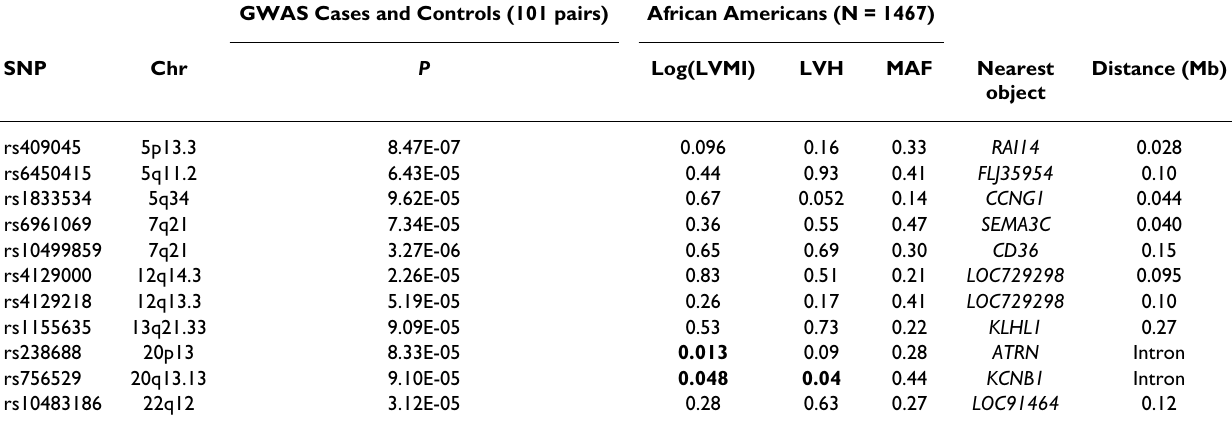
Table 5: Results (as P values) from the validation study genotyping and association analyses for the African American sample.* GWAS Cases and Controls (101